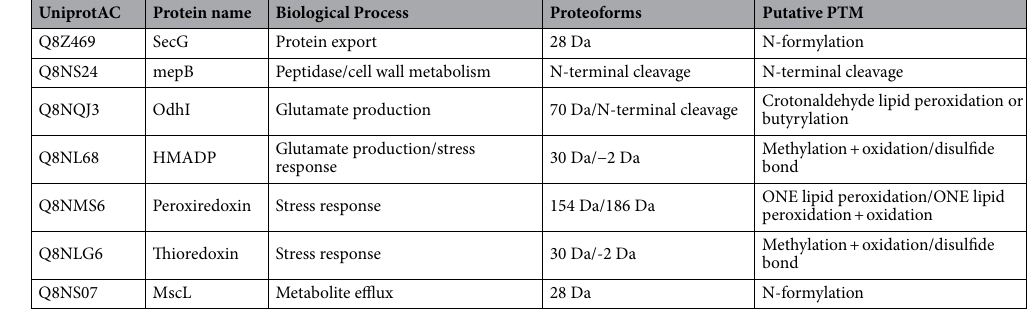
Table 1. Proteoforms with potential metabolism regulation function and of biotechnological interest. Proteoforms that presented a potential involvement in the regulation of metabolism or important biotechnological processes are represented by their corresponding protein names, Uniprot accession code (AC) and identified mass shift or sequence cleavage. Putative post-translational modifications (PTM) were defined based on identified mass shifts using the unimod database (https:// www. unimod. org).